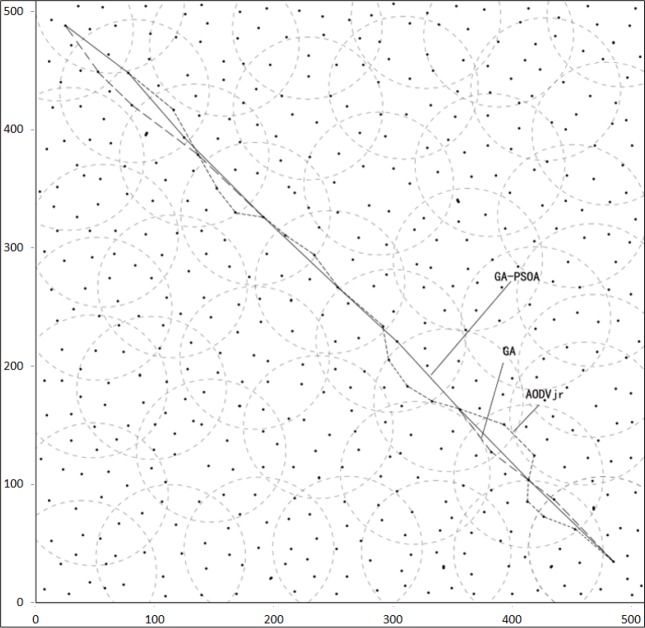
ZigBee network routing layout after simulation.